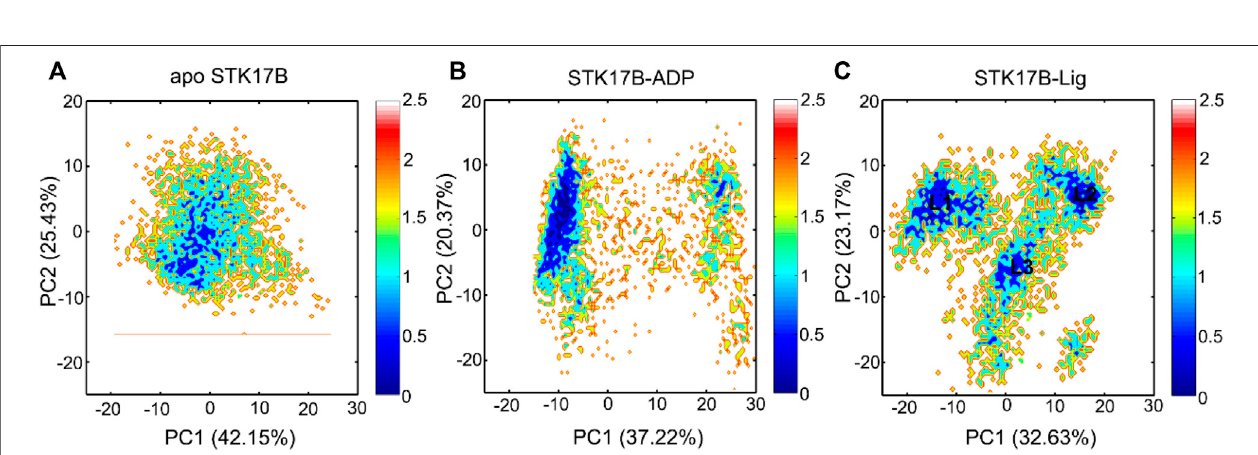
Frontiers in Molecular Biosciences |